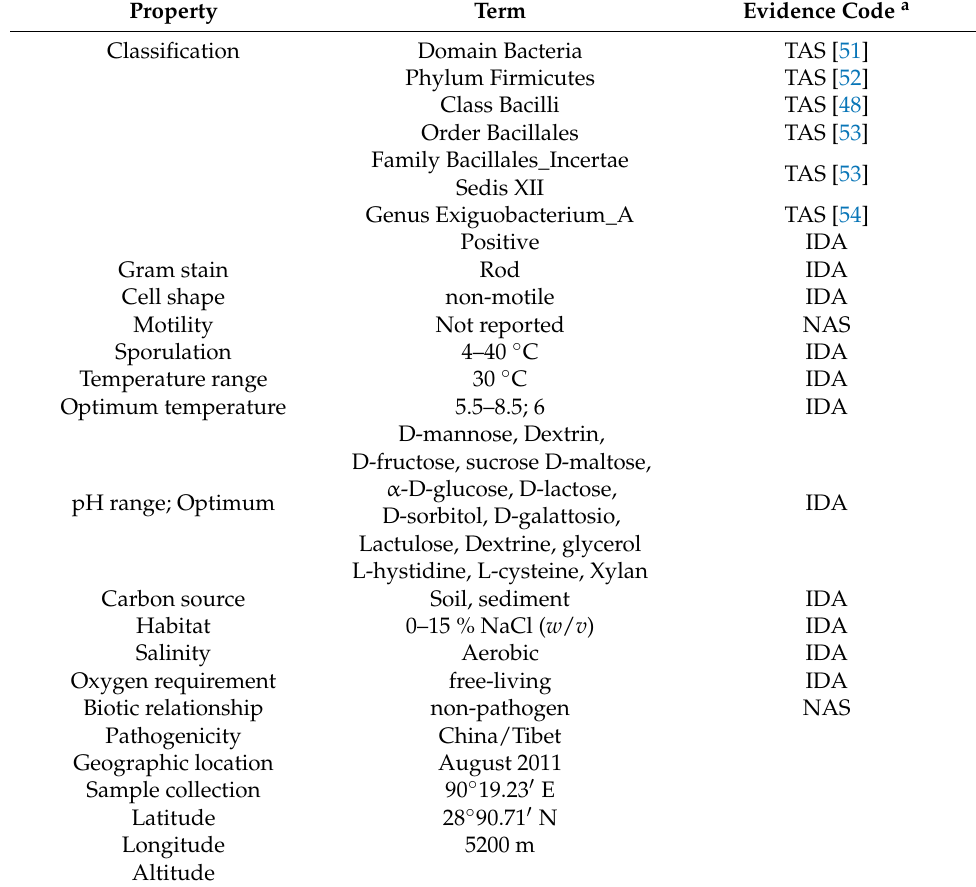
Table 1. Classification and general features of strain